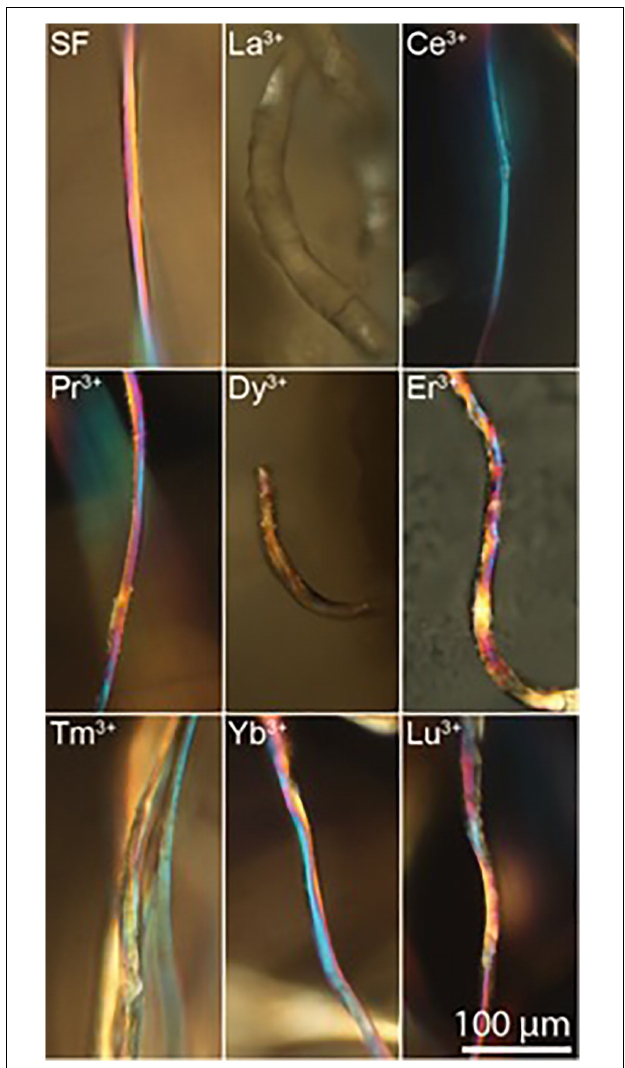
FIGURE 6 | Birefringence images of regenerated Ln + 3 /SF fibers (degummed SF, La + 3 /SF, Ce + 3 /SF, Pr + 3 /SF, Dy + 3 /SF, Er + 3 /SF, Tm + 3 /SF, Yb + 3 /SF, and Lu + 3 /SF).